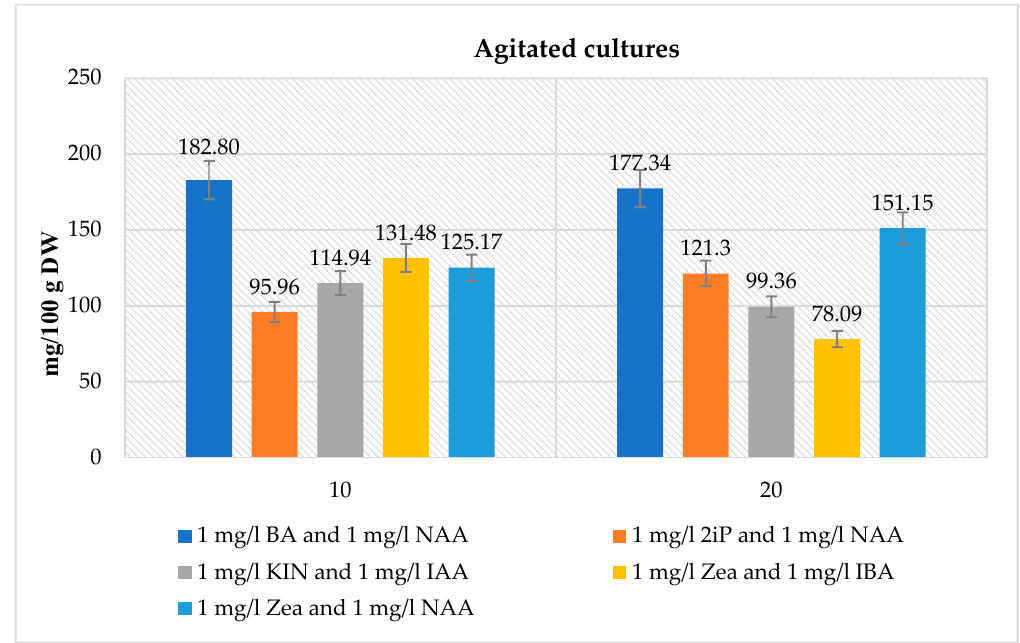
Figure 3. The maximal total glucosinolate contents (mg/100 g DW ± SD) in the extracts from agitated N. officinale microshoot cultures of tested different MS medium variants and growth cycles.